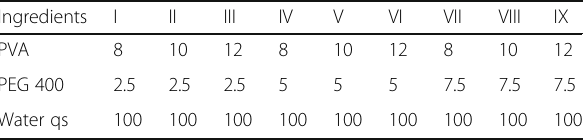
prepare the hydrogel sheets